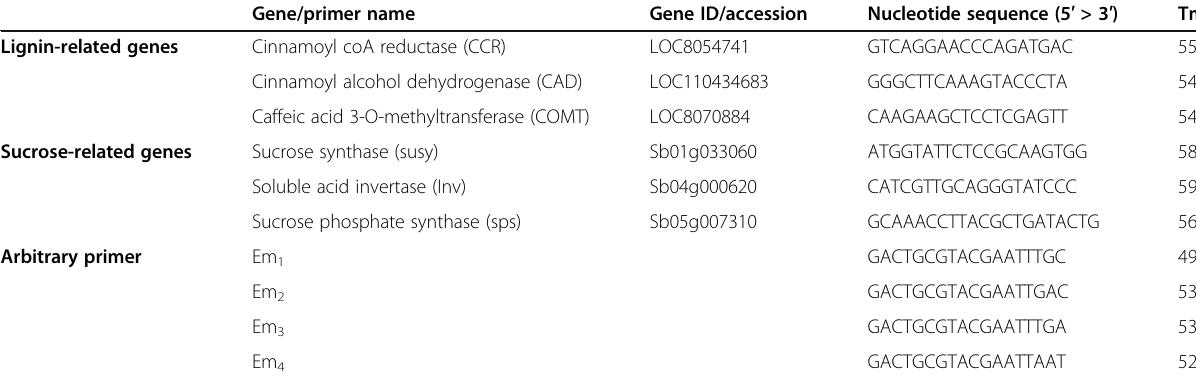
Table 2 Fixed and arbitrary primers used as TRAP